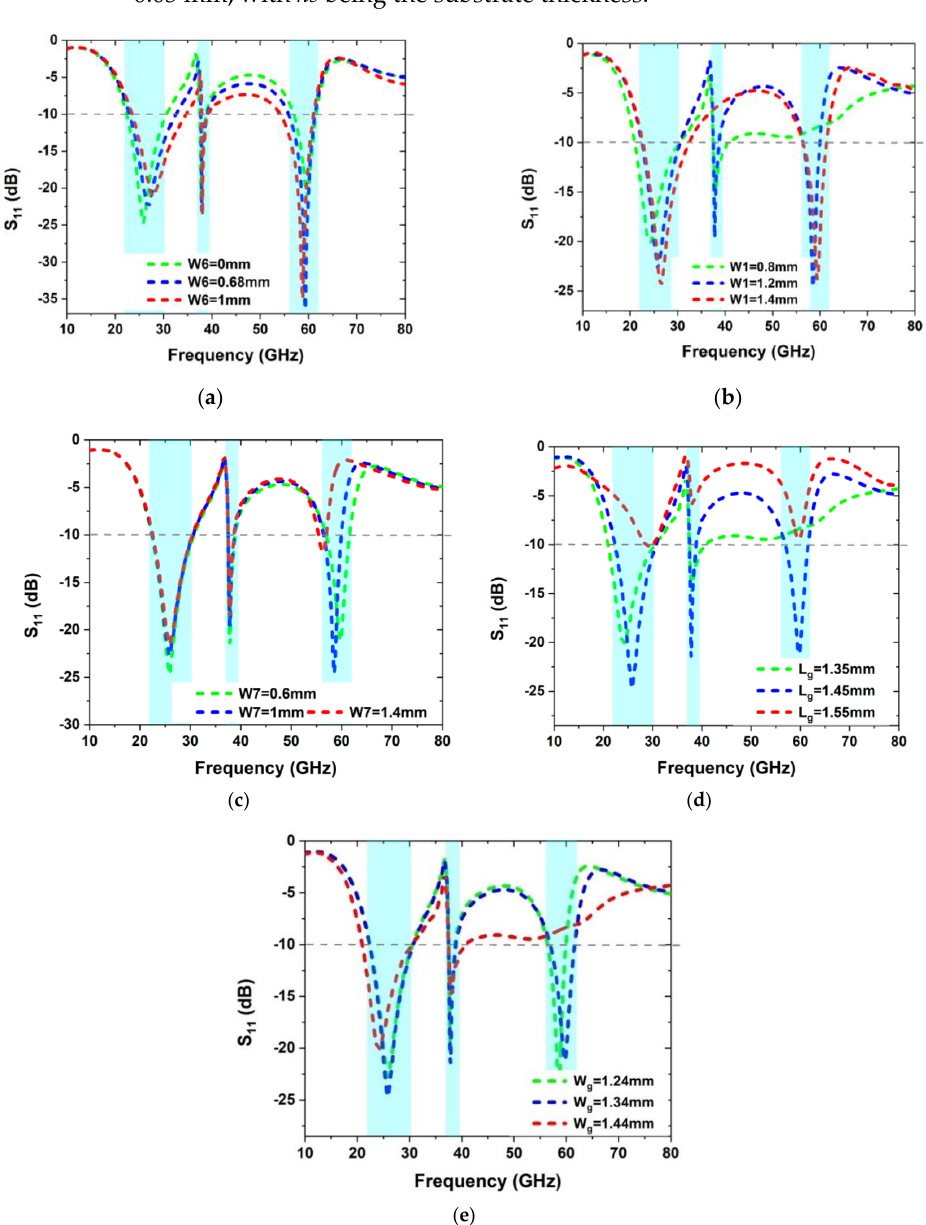
Figure 2. Parametric Analysis of the optimized parameters; ( a ) variation in W 6 , ( b ) variation in W 7 , ( c ) variation in W 1 , ( d ) variation in L g , and ( e ) variation in W g .